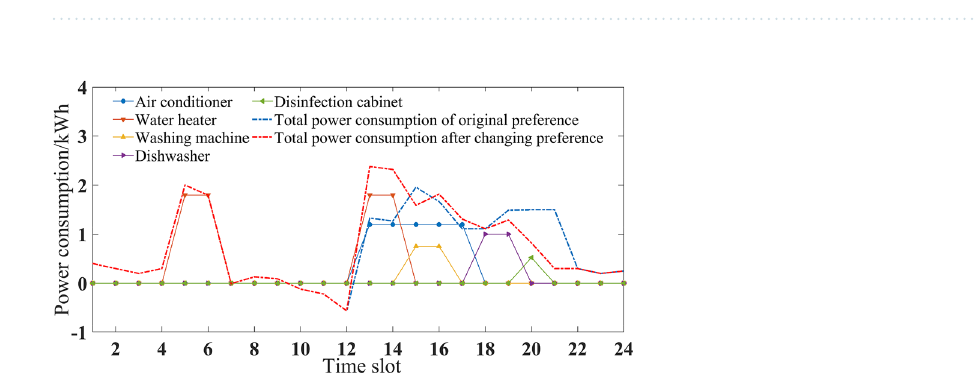
Table 6. Preference coefficient in summer.